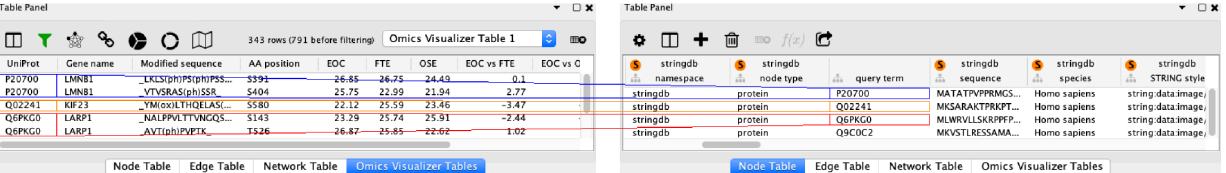
Figure 3. An Omics Visualizer table (left) and a node table (right) from a STRING network. Both tables can be linked together using the key column ‘UniProt’ from the Omics Visualizer table with the key column ‘query term’ from the node table. The color boxes identify the key values used to link the two tables, the color lines emphasize the link between the rows of the two